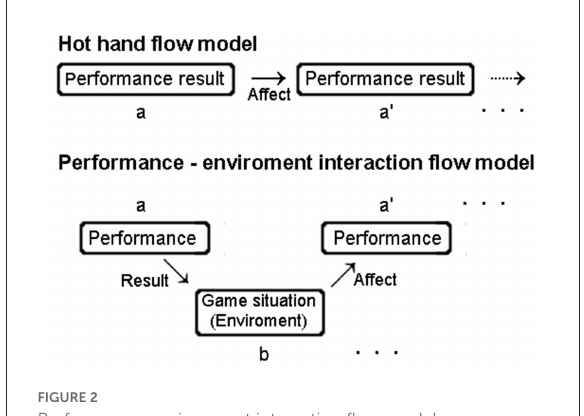
FIGURE2 Performance-environment interaction flow